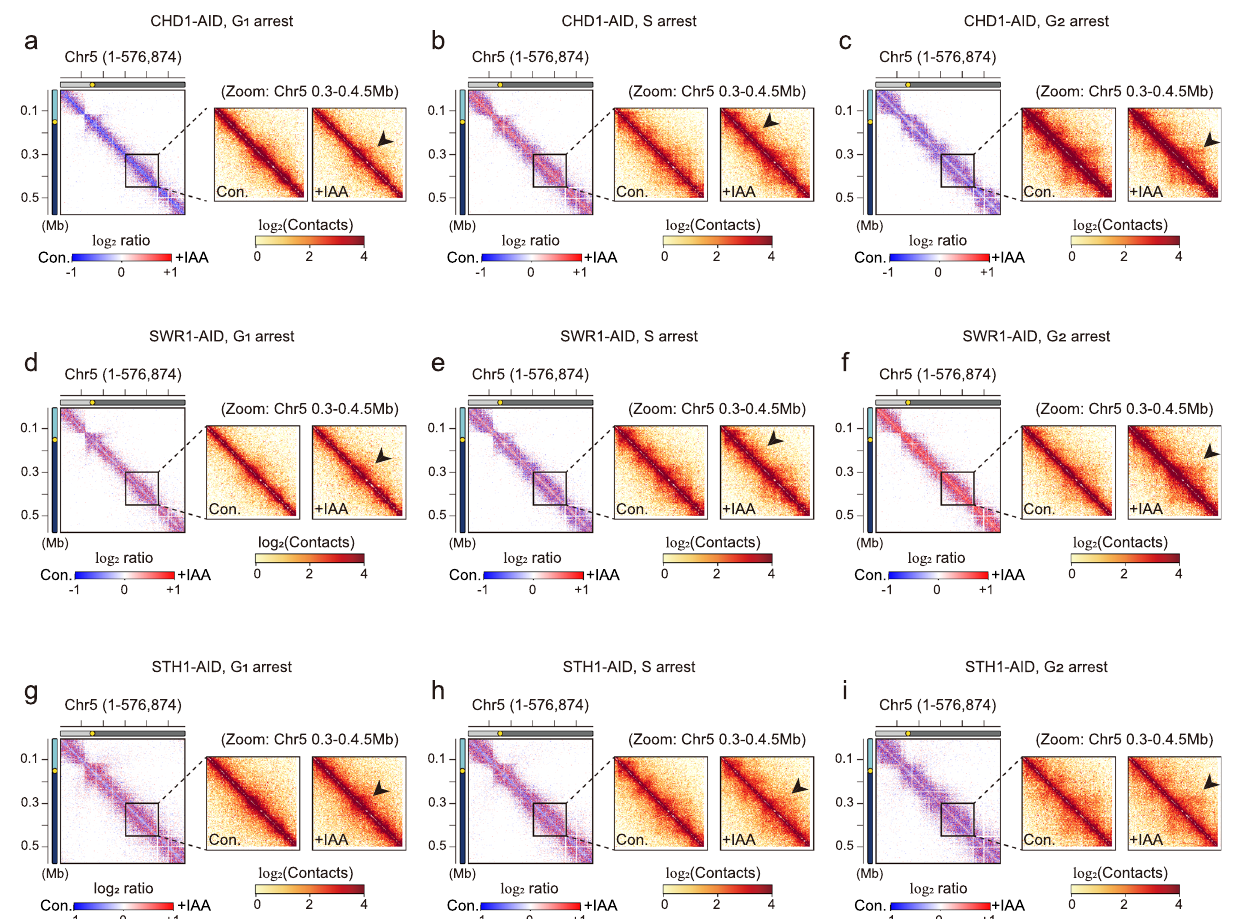
Fig. 1 The 3D architecture of yeast chromatin is dynamically regulated by chromatin remodelers throughout the cell cycle. a – i Contact maps (1-kb resolution) of chromosome 5 (576,874 bp) for CHD1-AID (a – c), SWR1-AID (d – f), and STH1-AID (g – i) strains at G 1 (a, d, g), S (b, e, h), and G 2 (c, f, i) phases. The left panels show the log 2 ratio matrix of contact maps for knockdown versus control samples, and the two right panels show zoom-in matrices of chromosome 5 (0.3 – 0.45 Mb) for the control ( ‘ Con. ’ ) and knockdown ( ‘ + IAA ’ ) conditions. Schematic representations including genomic distances are displayed on the left side of each contact map. Yellow dots indicate the point centromere of the